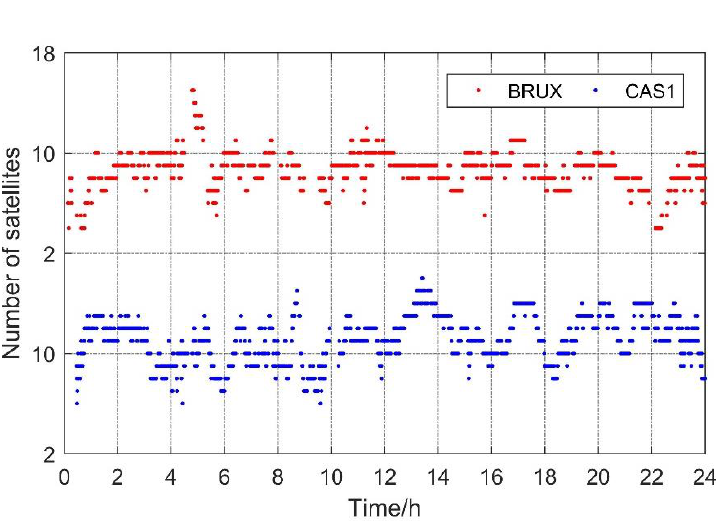
Figure 4. Number of satellites before narrow-lane ambiguity resolution.